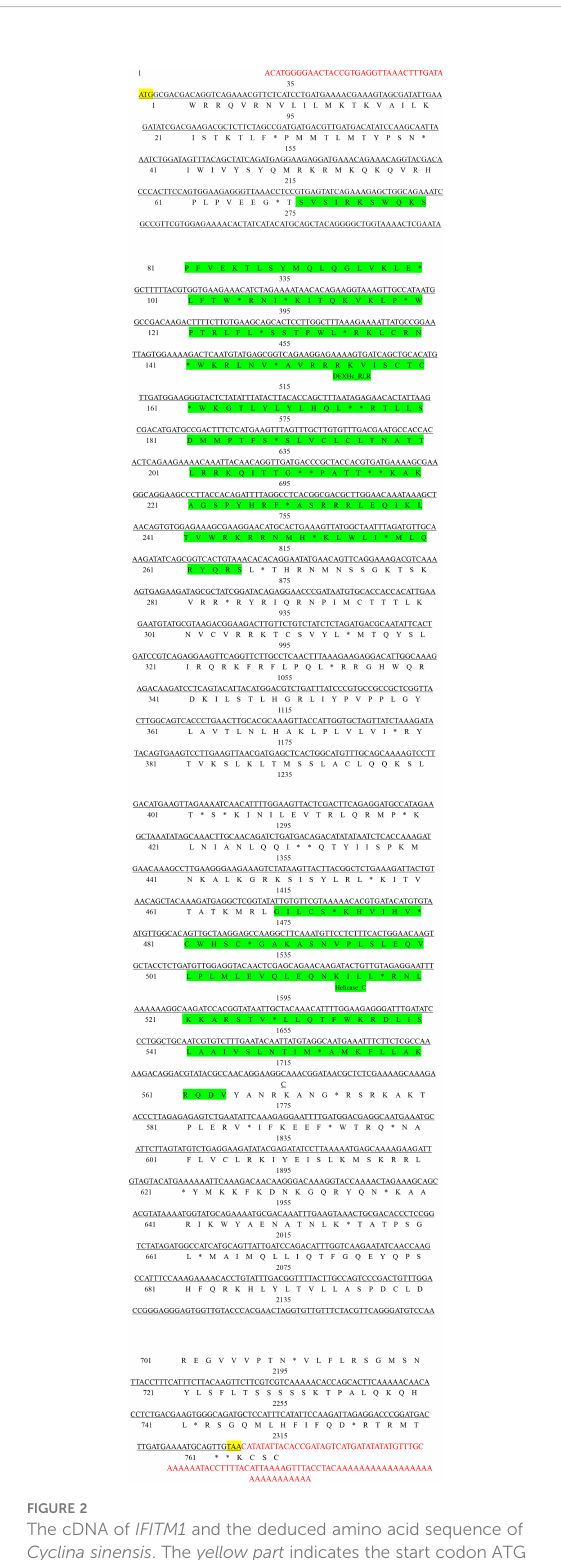
FIGURE 2 The cDNA of IFITM1 and the deduced amino acid sequence of Cyclina sinensis . The yellow part indicates the start codon ATG and the stop codon TAA, the underlined area indicates the open reading frame (ORF), and the green part indicates the conserved domain of IFITM1